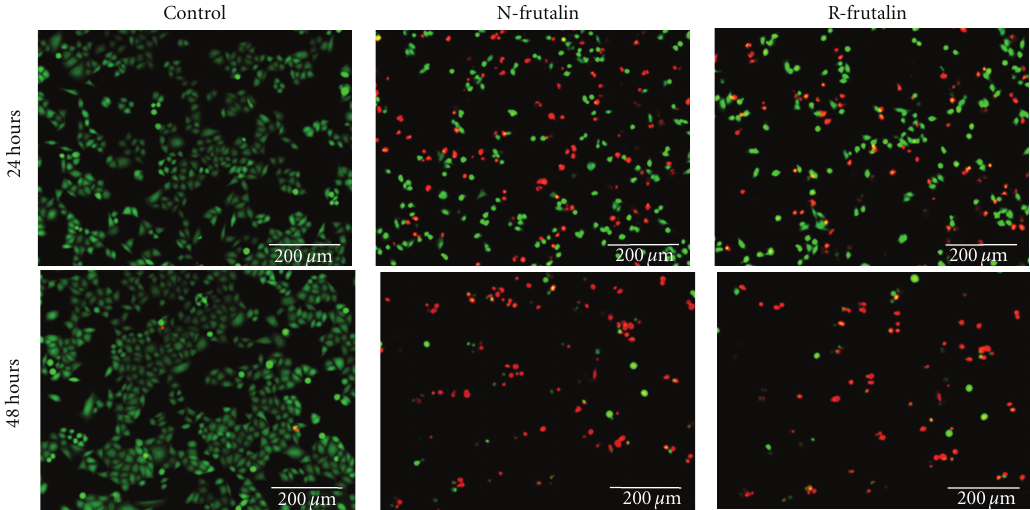
Figure 3: E ff ect of n-frutalin and r-frutalin on HeLa cells viability. Merged fluorescence photographs for the viability evaluation of HeLa cells cultured for 24 and 48 h in the presence of n-frutalin and r-frutalin (both at 100 μ g/mL) using the LIVE/DEAD Viability/Cytotoxicity Kit for mammalian cells are shown. In the control, cells were incubated with PBS bu ff er instead of the lectins. Live cells are stained in green, and dead cells are stained in